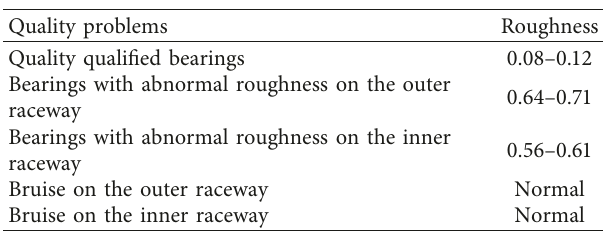
Table 2: Roughness of test bearings.